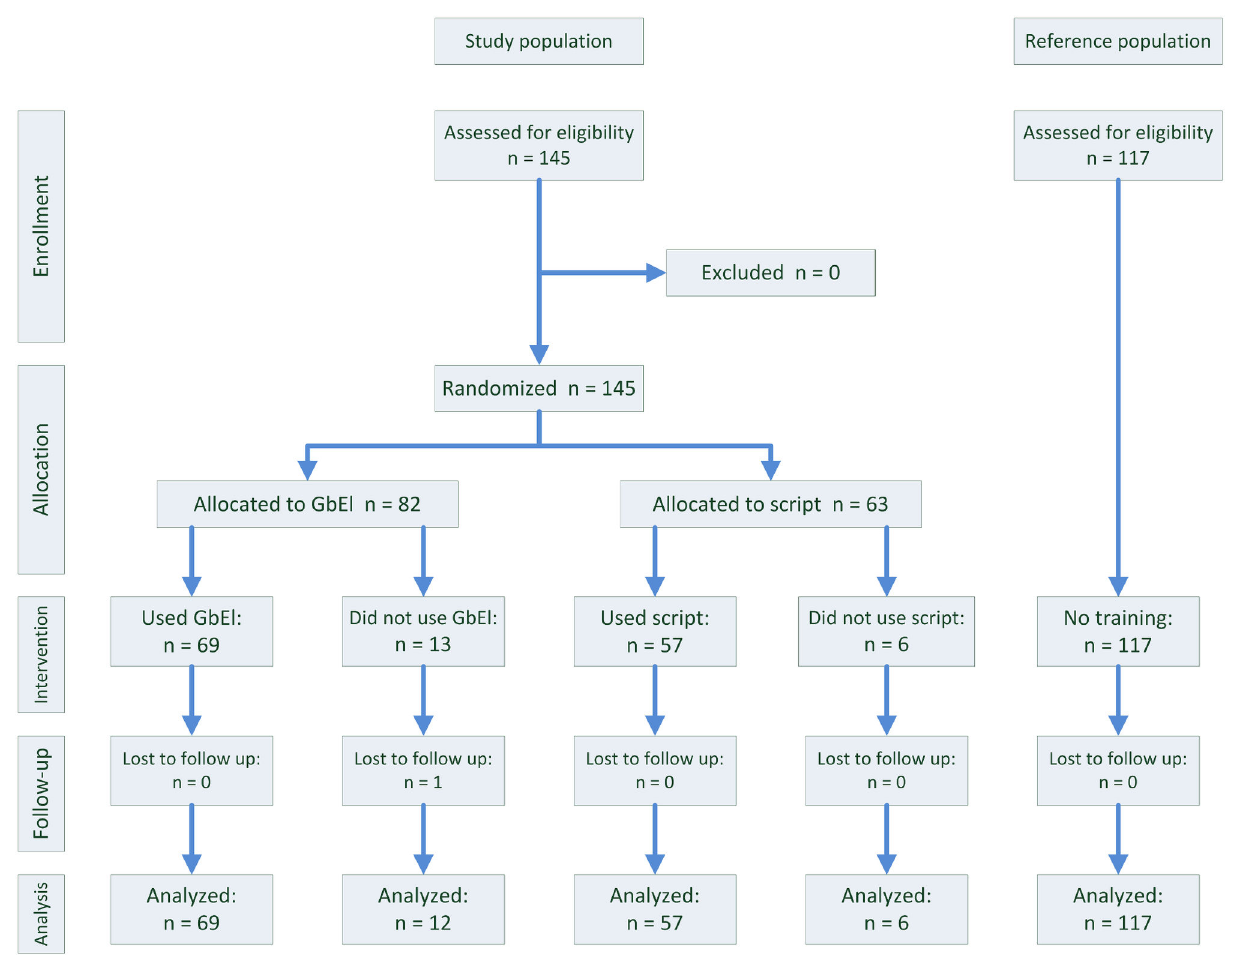
Figure 1. CONSORT Diagram. A total of 145 students were randomized of which 144 students were